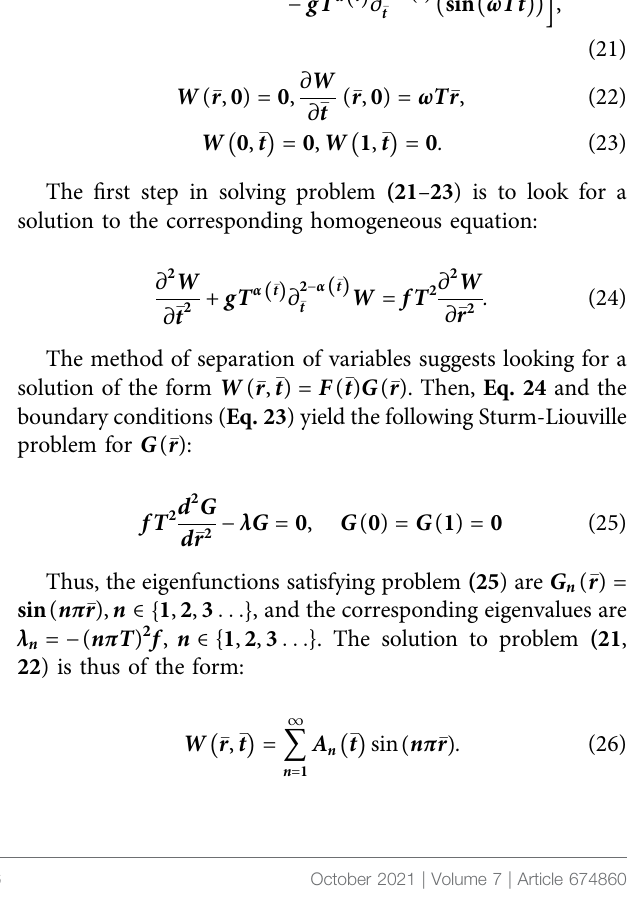
Frontiers in Mechanical Engineering |